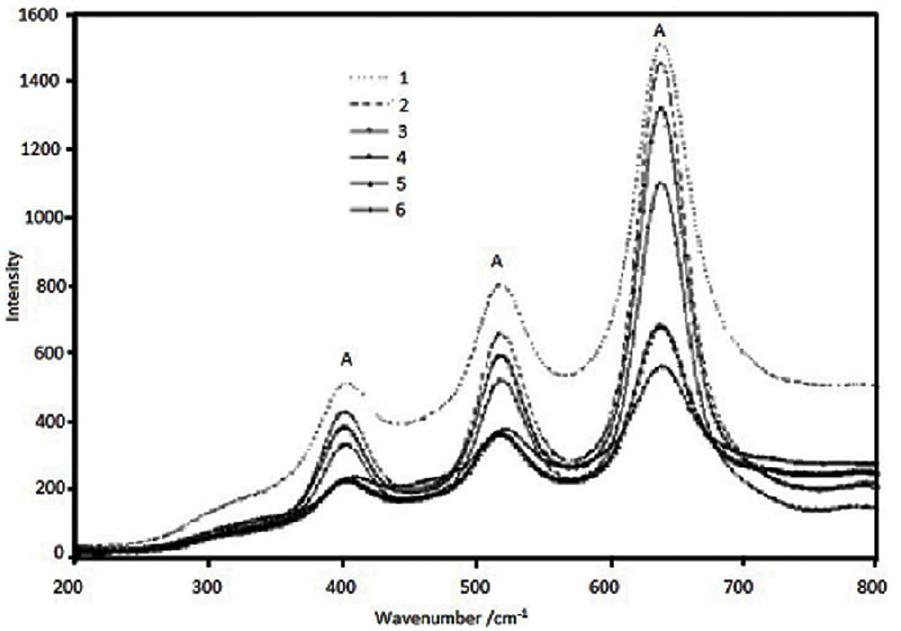
doi:10.1371/journal.pone.0021082.g002